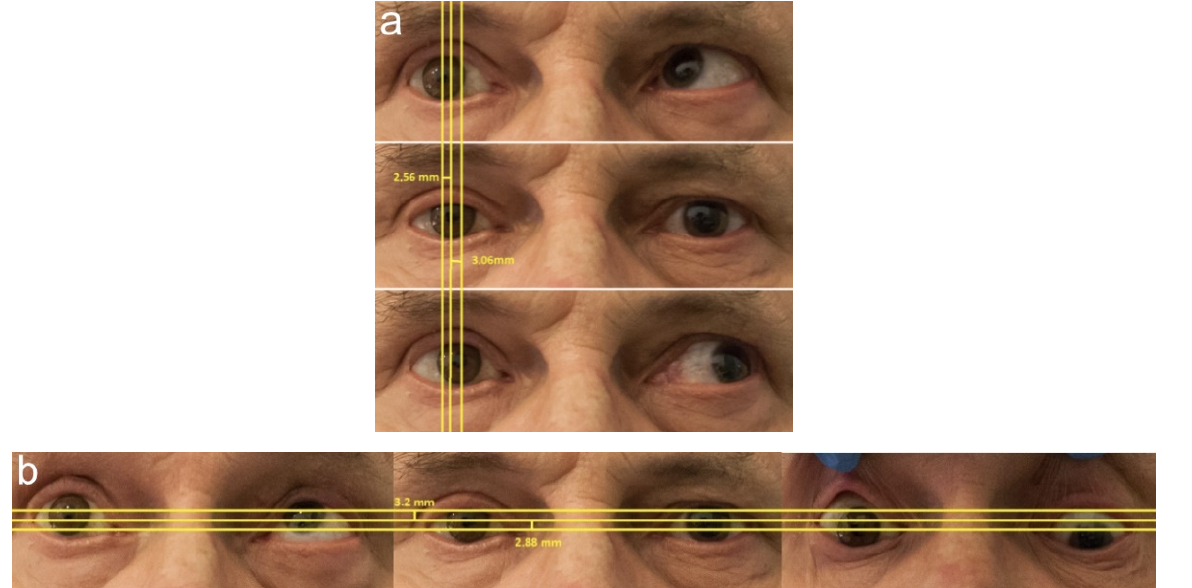
Figure 1. Measurement of eye motility in millimeters: ( a ) the horizontal direction (temporal and nasal); ( b ) the vertical direction (up and down) using a previously described method by Guthoff et al. [21]. Source: Division of Ophthalmology and Ocular Oncology, Jagiellonian University Medical College; own material.